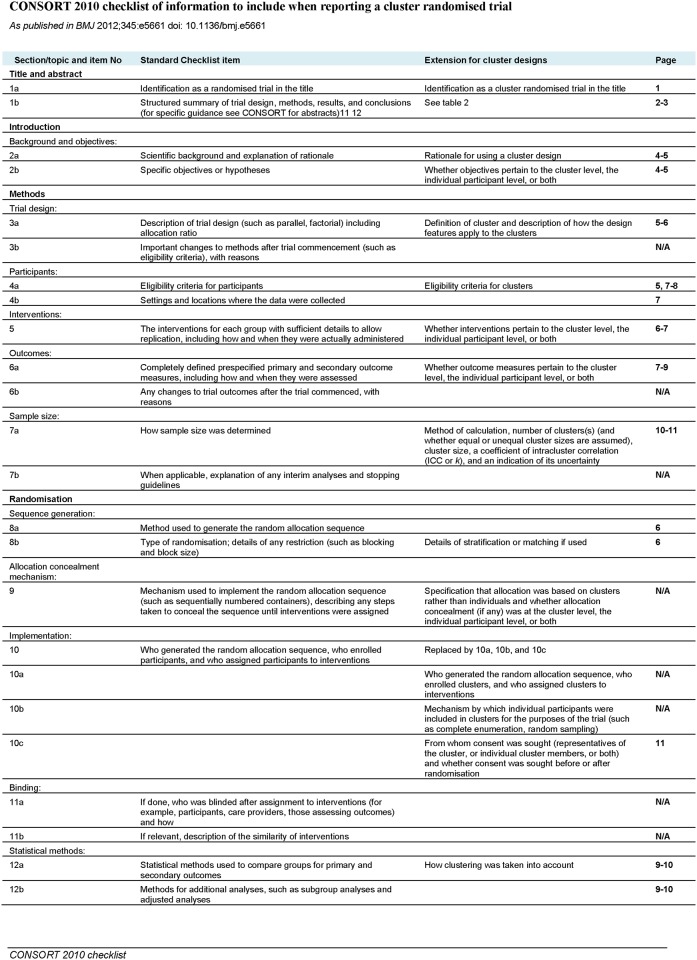
CONSORT 2010 checklist of information to include when reporting a cluster randomised trial.Suggested modifications to the CONSORT 2010 cluster extension for reporting of stepped wedge cluster randomised trials.